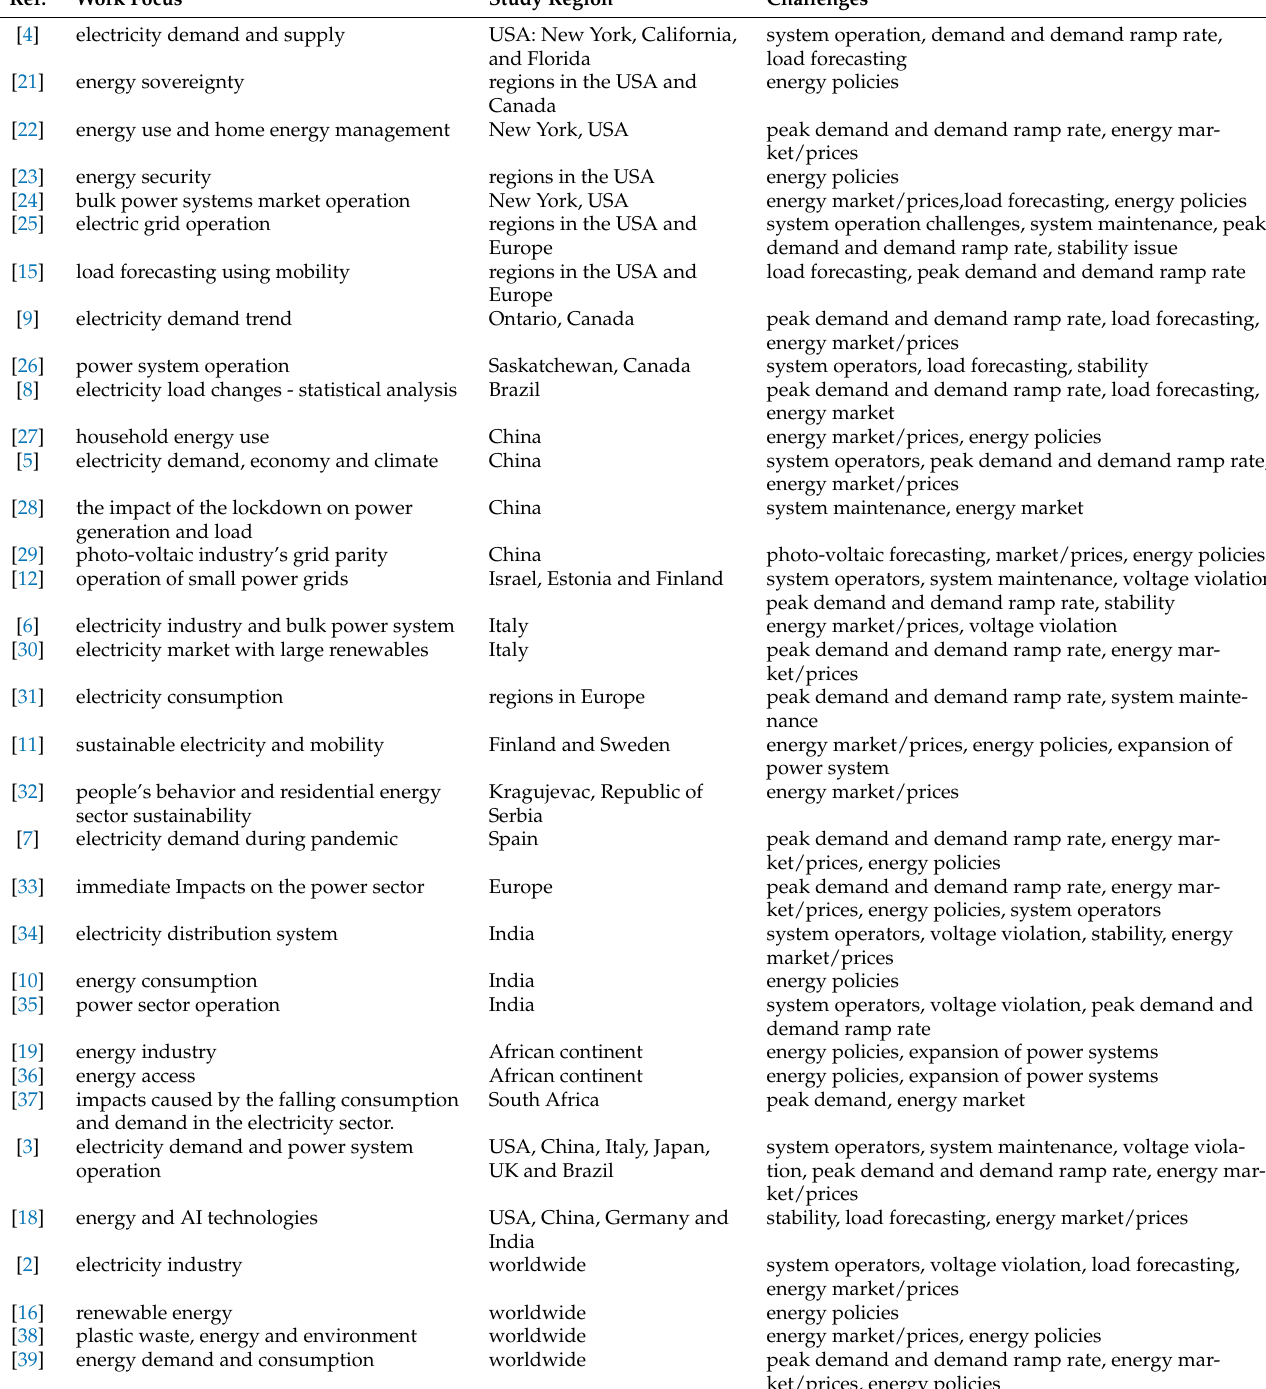
Table 1. Summary of works focusing on the impacts of COVID-19 on energy systems and markets.